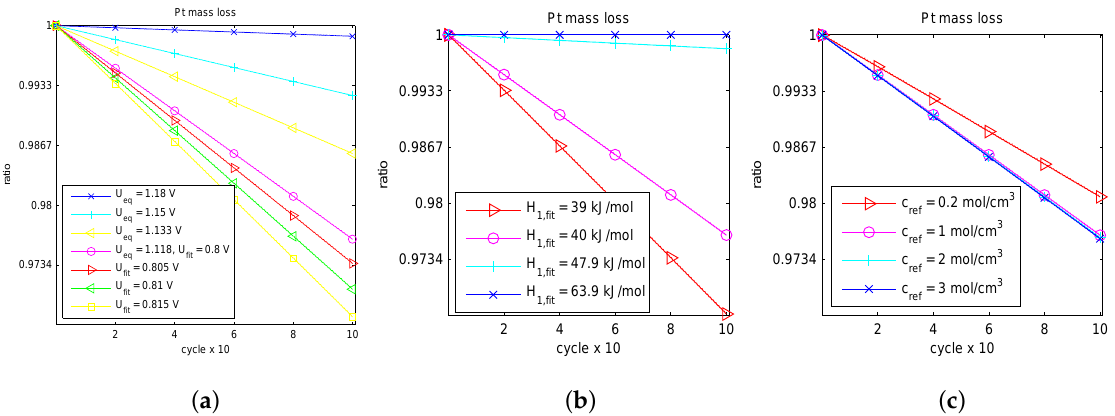
Figure 2. Pt loss when fitting: ( a ) Pt dissolution and oxide formation bulk equilibrium voltage; ( b ) Pt dissolution activation enthalpy; ( c ) reference ion